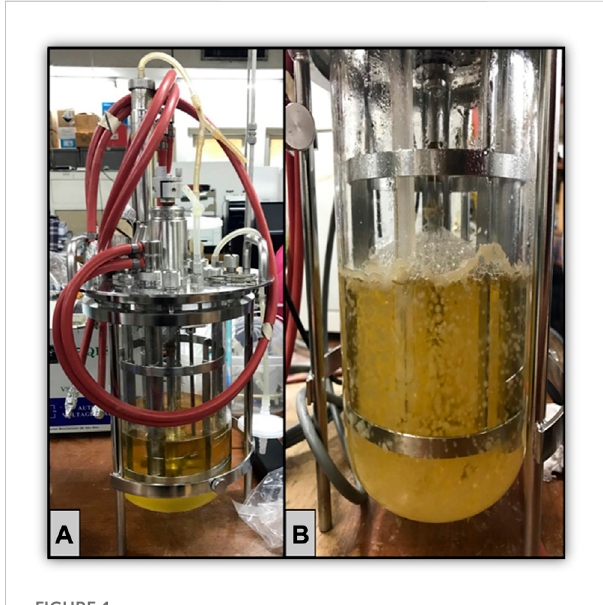
Large-scale microbial biomass production in a stirred-tank bioreactor 2-L (Sartorius Biostat A plus). (A) Without inoculation. (B) With microbial